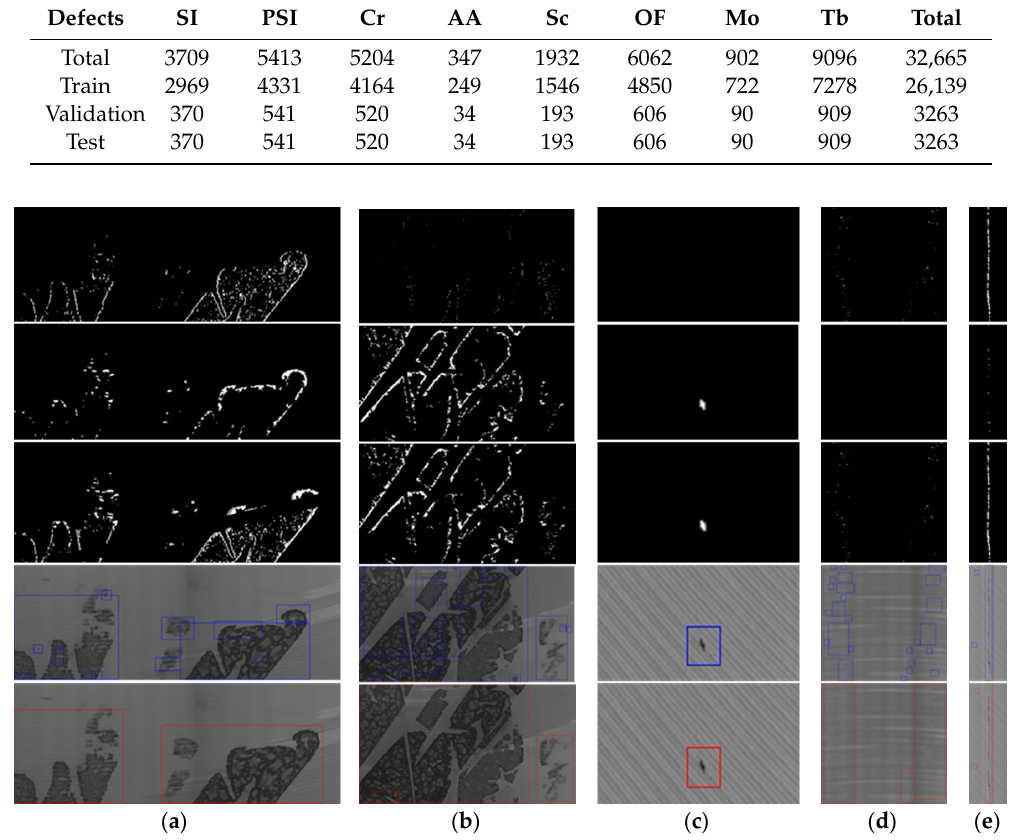
Figure 16. ROI extraction results of different defects: ( a ) OF; ( b ) OF; ( c ) Oil; ( d ) PSI; ( e ) Sc.